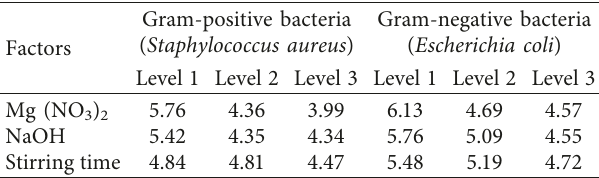
Table 2: The main effects of studied factors at different levels on the survival of